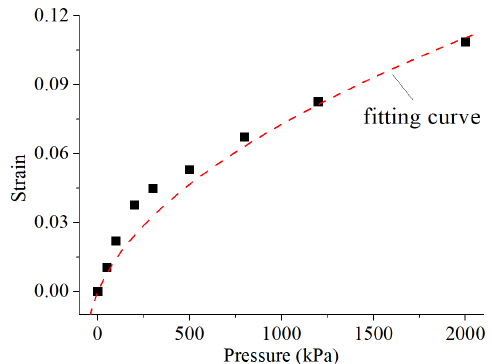
Figure 11. Relationship between strain ε and pressure p.